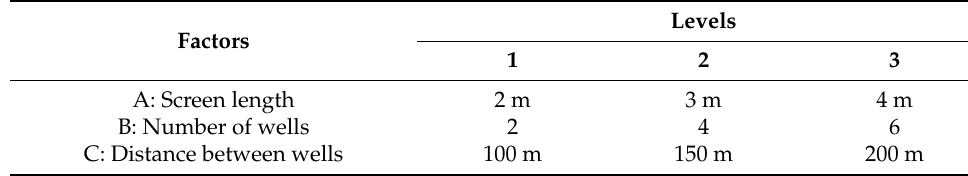
Table 6. Orthogonal experimental design and results.